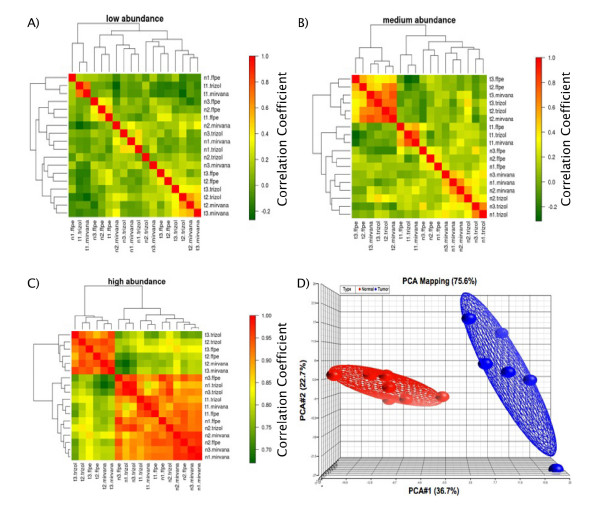
Correlation heatmaps and PCA mapping for paired fresh-frozen and FFPE tissues. Correlation heat-maps demonstrating hierarchical clustering among 3 normal lymph nodes (n1-n3) and 3 mantle cell lymphomas (t1-t3) extracted using different techniques using: A) Low abundance miRs B) Medium abundance miRs C) High abundance miRs. Panel D) shows principal component analysis (PCA) confirming the similarity of miR expression between tumours (red), and normal samples (blue), irrespective of tissue origin (FFPE vs. fresh-frozen).